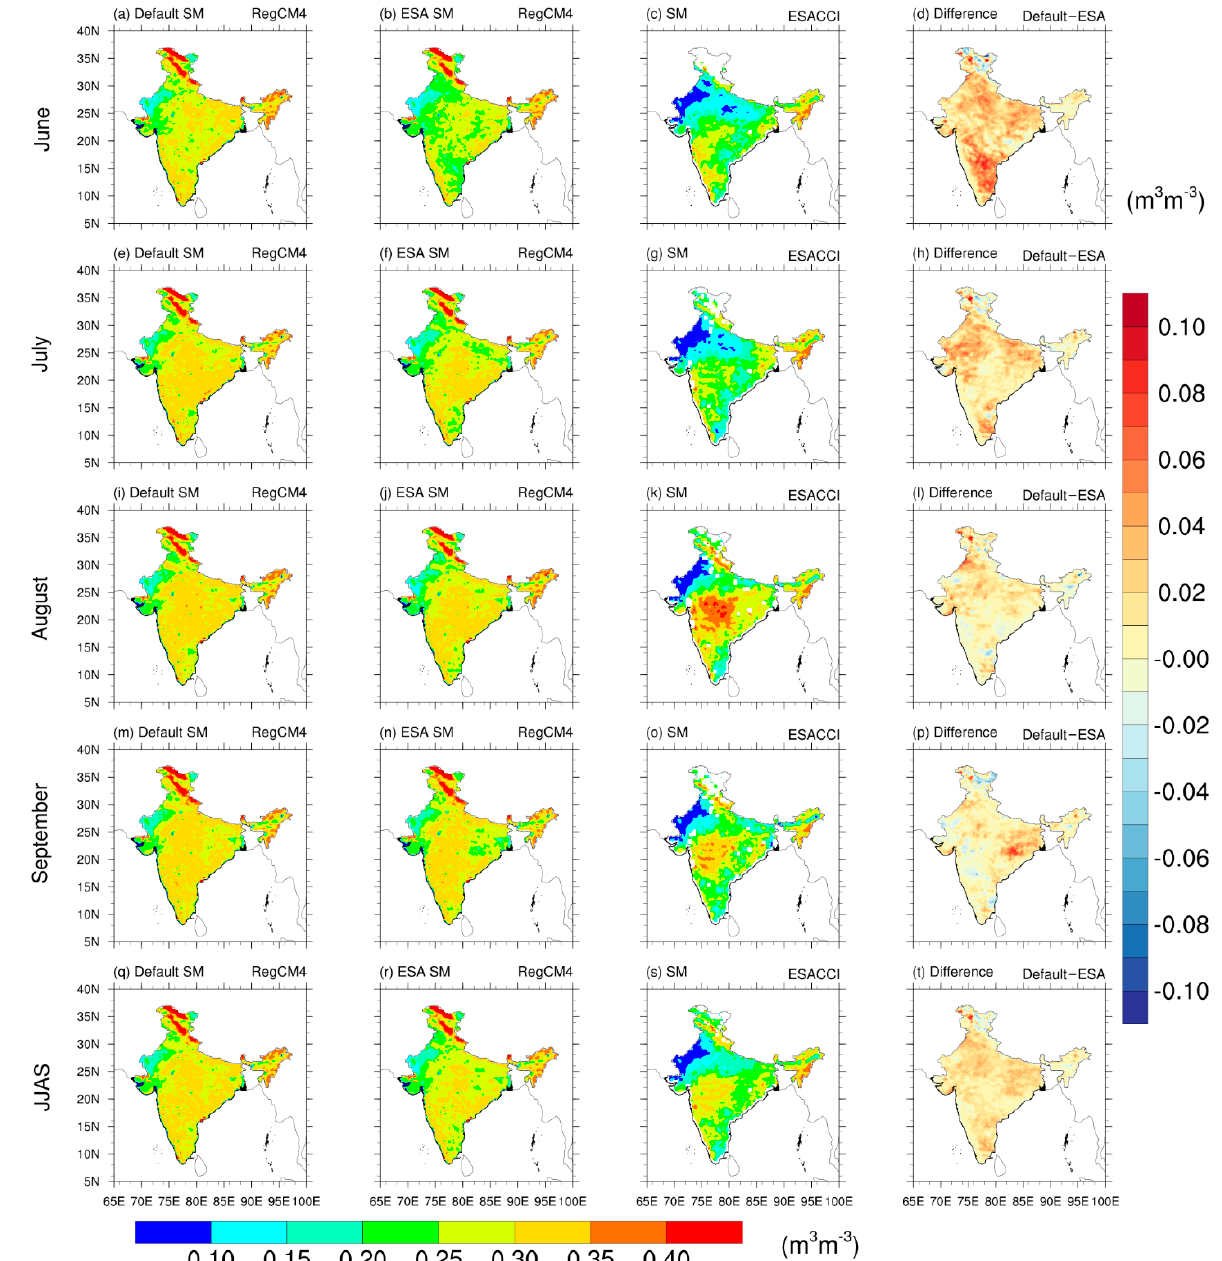
Figure 6. Soil moisture (m 3 m − 3 ) at monthly and seasonal scale for the year 2002. Four columns represent simulated results from two setups, viz., default (1st column) and ESA (2nd column), ESA ‐ CCI soil moisture (3rd column) and the difference from the two model setups (4th column). The five rows correspond with results for ( a – d ) June, ( e – h ) July, ( i – l ) August, ( m – p ) September and ( q – t ) JJAS means.